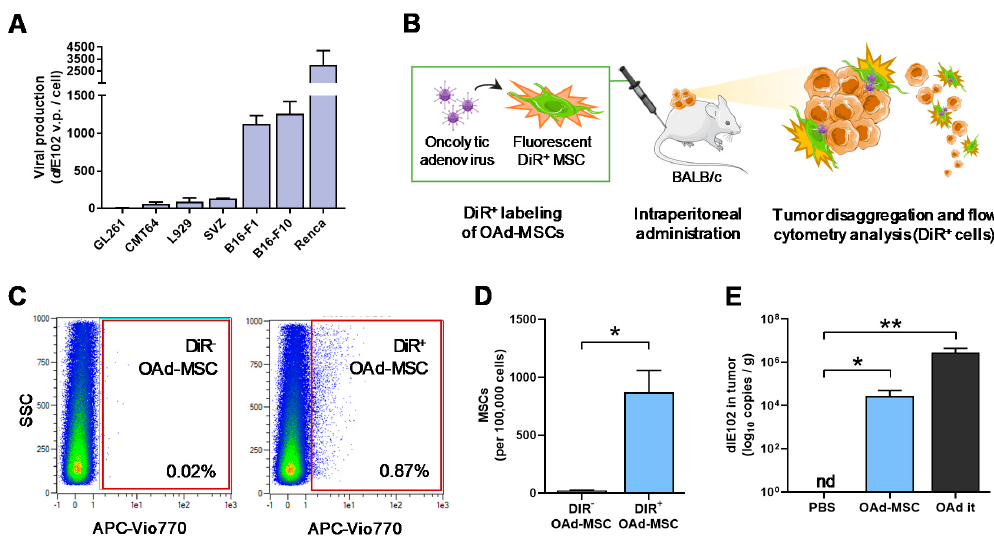
Figure 2. In vitro viral production in mouse tumor cell lines and in vivo tumor-homing of